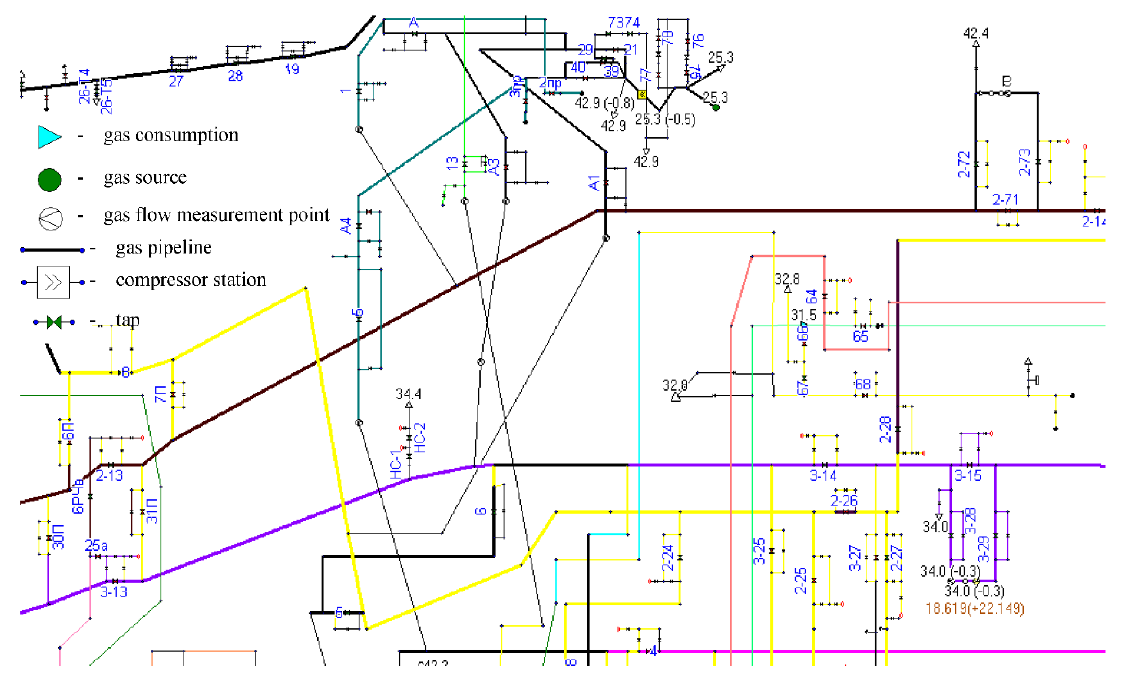
Figure 5. Underground gas storage facilities on a fragment of the piping and instrumentation diagram of the GTS of Ukraine.